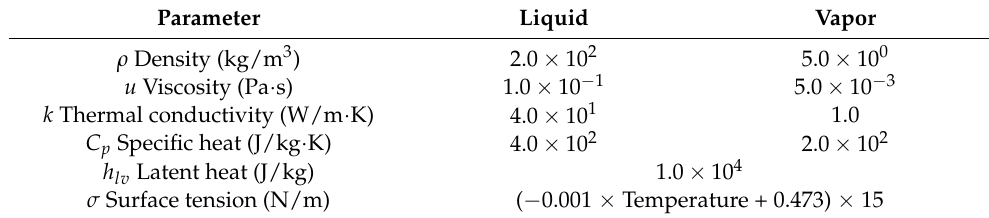
Table 2. Properties of the working fluid in